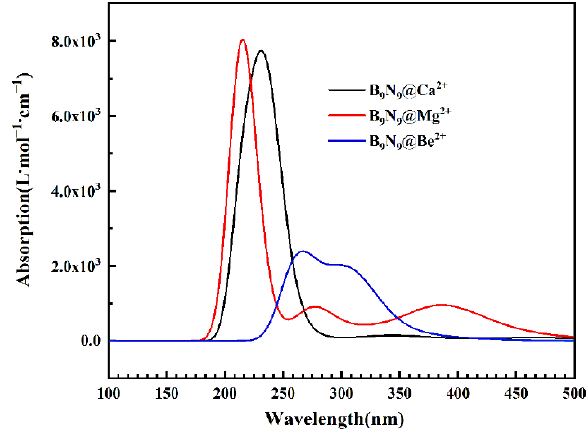
2+ , Mg 2+ , and Ca 2+ for B